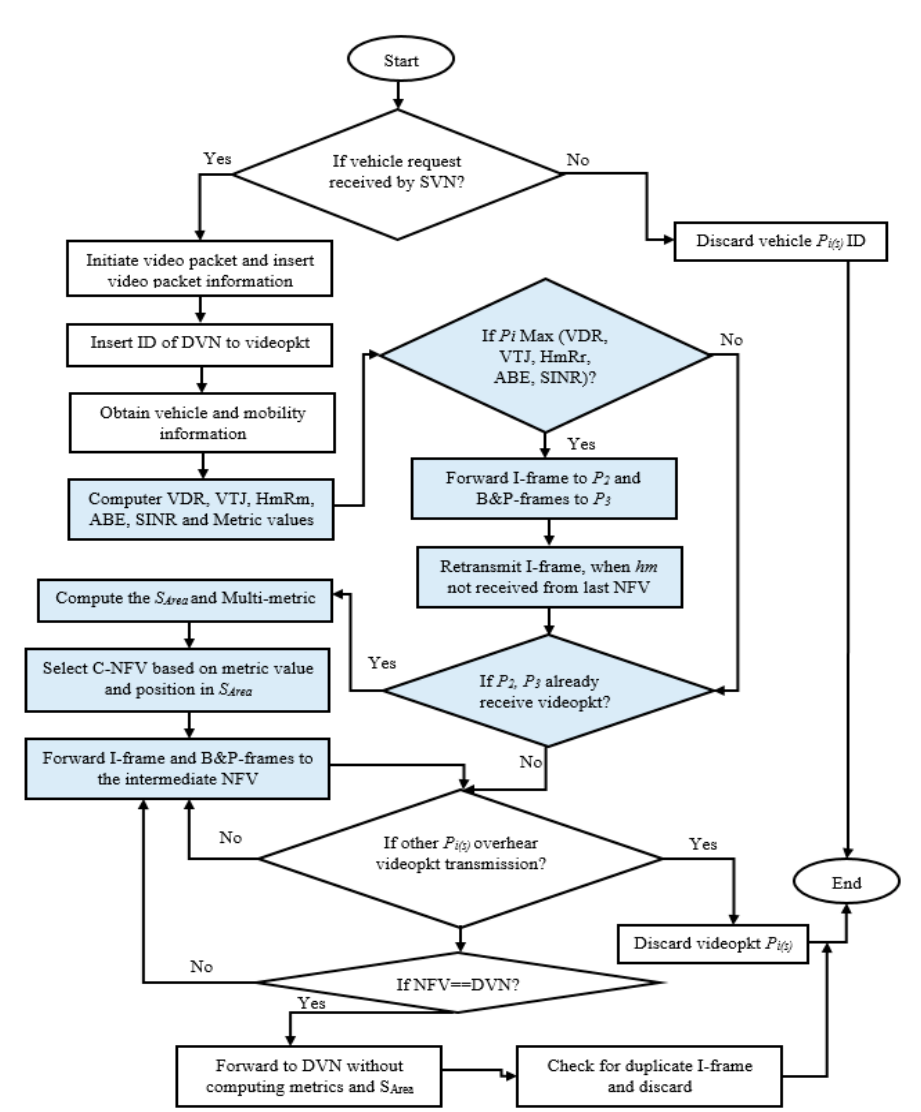
Figure 3. Packet Forwarding-based Road-based Multi-metric Forwarder Evaluation scheme for Multipath Video Streaming (RMF-MVS) Flowchart.